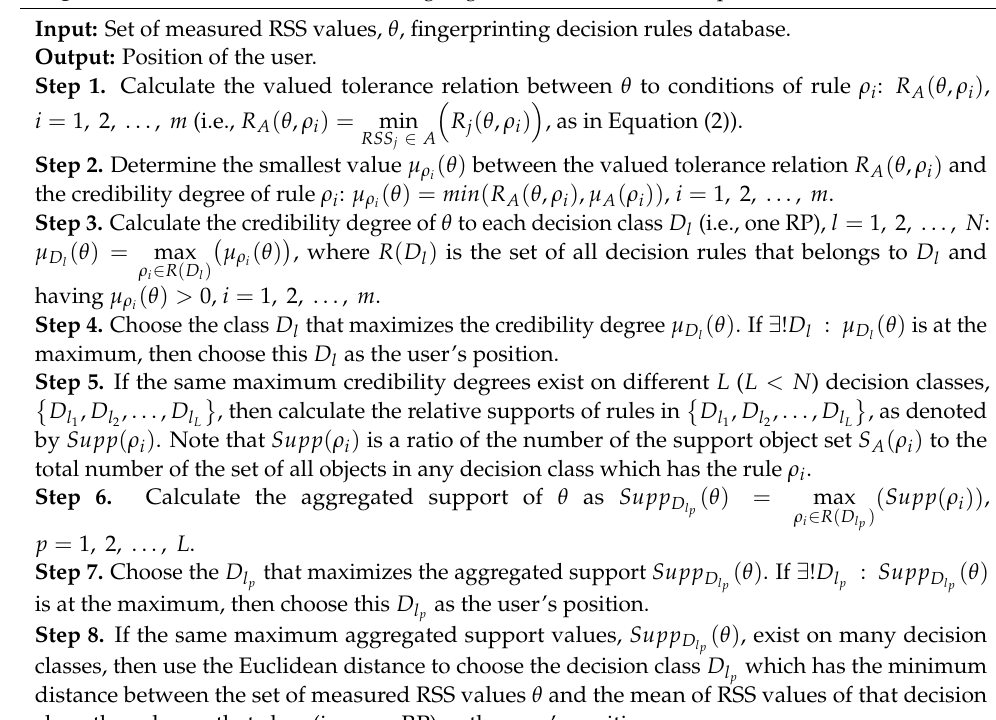
Algorithm 2: The Advanced Positioning Algorithm Based on the Proposed VTRS–DR